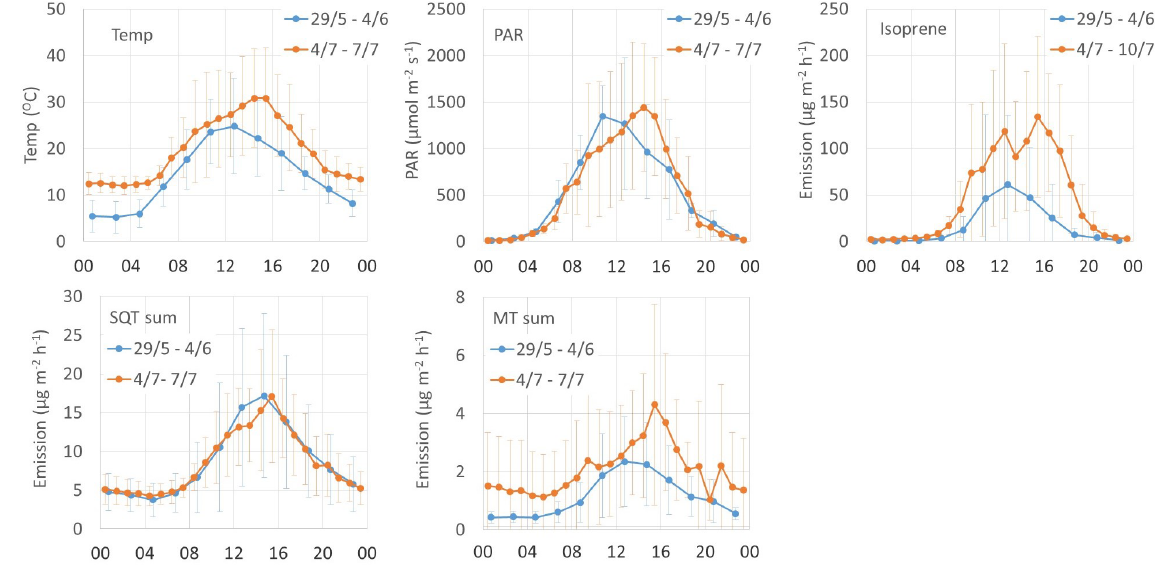
Figure 7. Diurnal variation in chamber temperature, PAR and emission rates (µgm − 2 h − 1 ) of isoprene, SQTs and